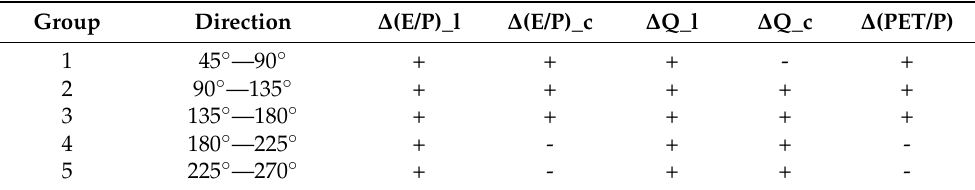
Table 8. Hydroclimatic condition group classified according to the direction of movement in the Budyko space (changes of evaporation index due to land use change, ∆ (E/P)_l; changes of evapora- tion index due to climate change, ∆ (E/P)_c; changes of runoff due to land use change, ∆ Q_l; changes of runoff due to climate change, ∆ Q_c; changes of aridity index, ∆ (PET/P)). Group Direction ∆ (E/P)_l ∆ (E/P)_c ∆ Q_l ∆ Q_c ∆ (PET/P) 1 45 ◦ —90 ◦ + + + - + 2 90 ◦ —135 ◦ + + + + + 3 135 ◦ —180 ◦ + + + + + 4 180 ◦ —225 ◦ + - + + - 5 225 ◦ —270 ◦ + - + +